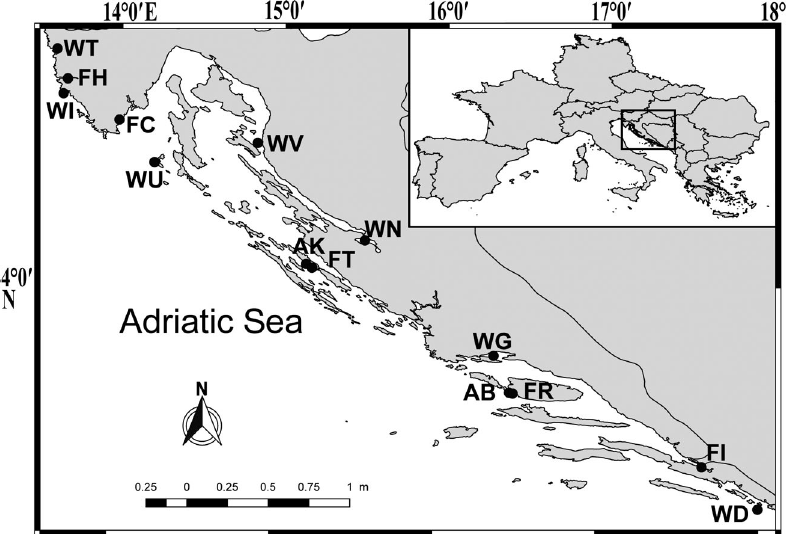
Fig. 1. Adriatic Sea, showing sampling locations of farm-associated, farmed and wild Sparus aurata populations along the eastern Adriatic coast. See Table 1